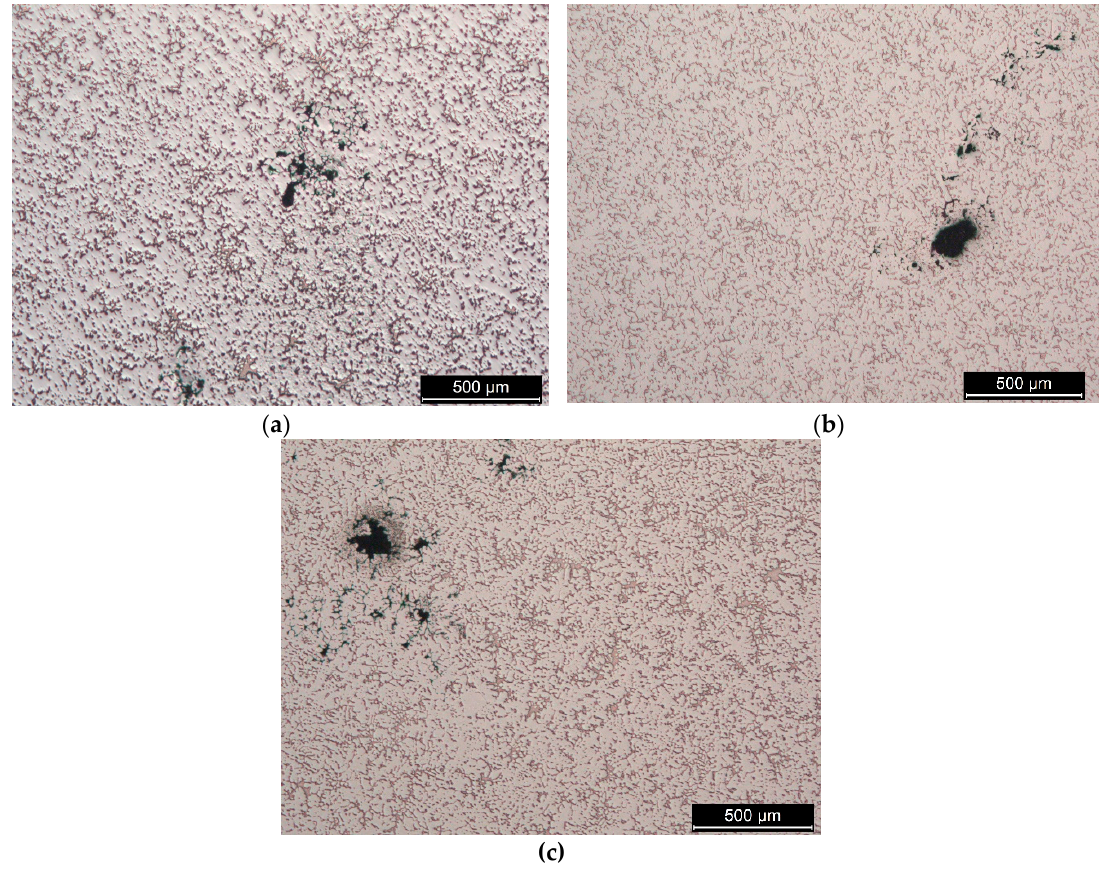
Figure 9. The produced Al–Cu alloy using USV. ( a ) Batch 15U, ( b ) batch 45U, and ( c ) batch 90U, all without chemical etching.